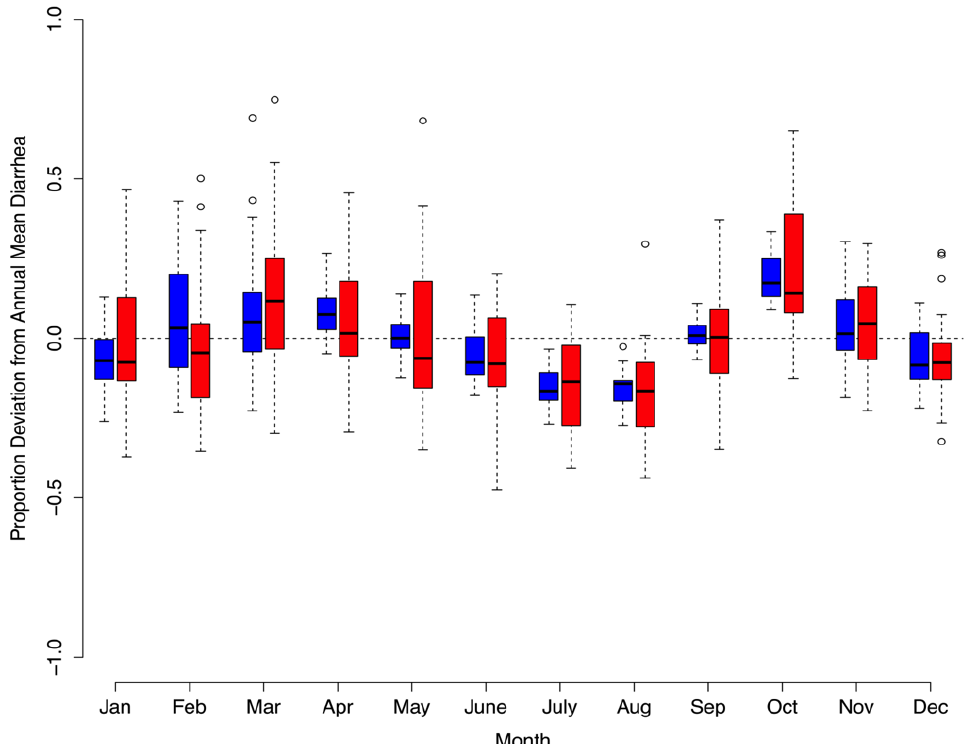
Figure 7. Comparison between predicted monthly values (blue box plots) and observed monthly values (red box plots) for the proportion deviation from the yearly average diarrhea in Botswana from